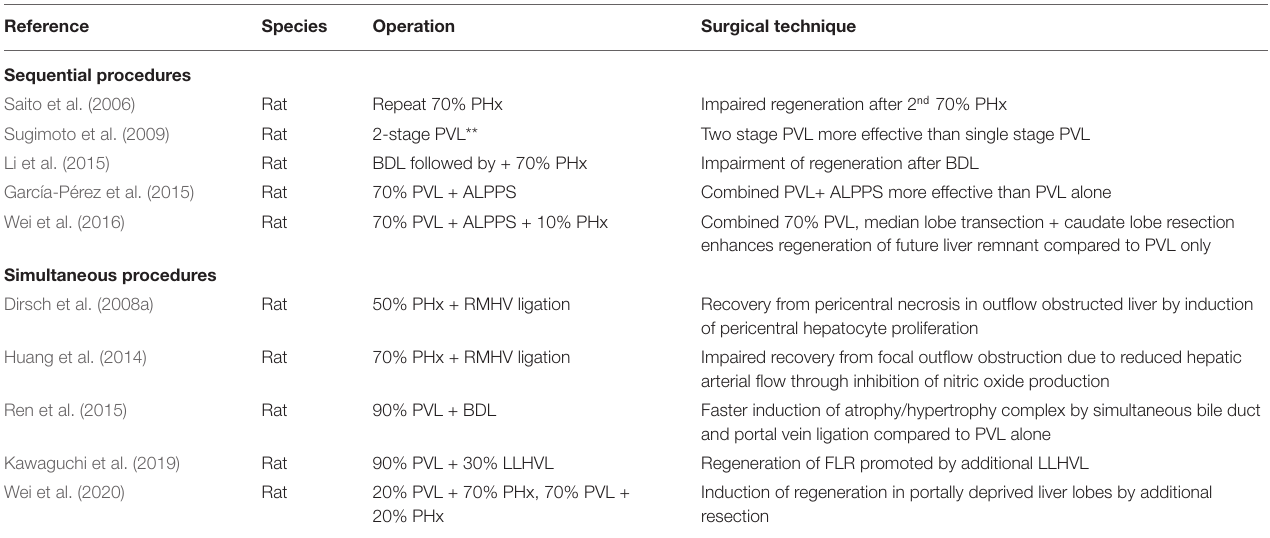
TABLE 2 | Selection of different rodent models of liver resection/partial hepatectomy (PHx).